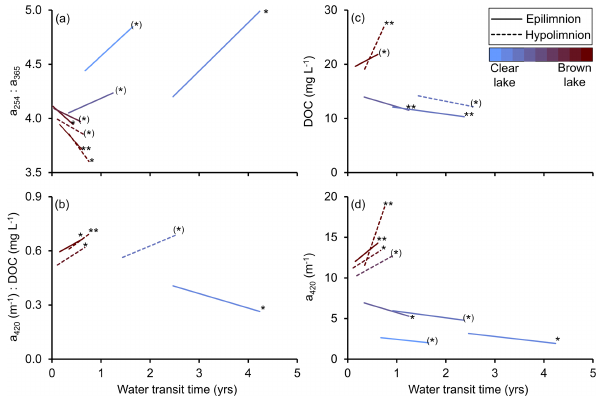
Figure 2. Linear regression lines for significant relationships be- tween different properties of DOC and the water transit time, shown for individual epilimnia (solid lines) and hypolimnia (dashed lines) of nine lakes in northern Sweden. The y axis variables are (a) the absorbance ratio A 254 : A 365 , (b) the ratio between absorbance at 420nm and DOC concentration, (c) DOC concentration, and (d) ab- sorbance at 420nm. Nonsignificant regression lines are not shown. For full statistical details and data plots, see Table S1 and Fig. S5, respectively. Significance: ∗ p < 0 . 01; ∗∗ p < 0 . 001; ( ∗ ) marginally significant p < 0 .